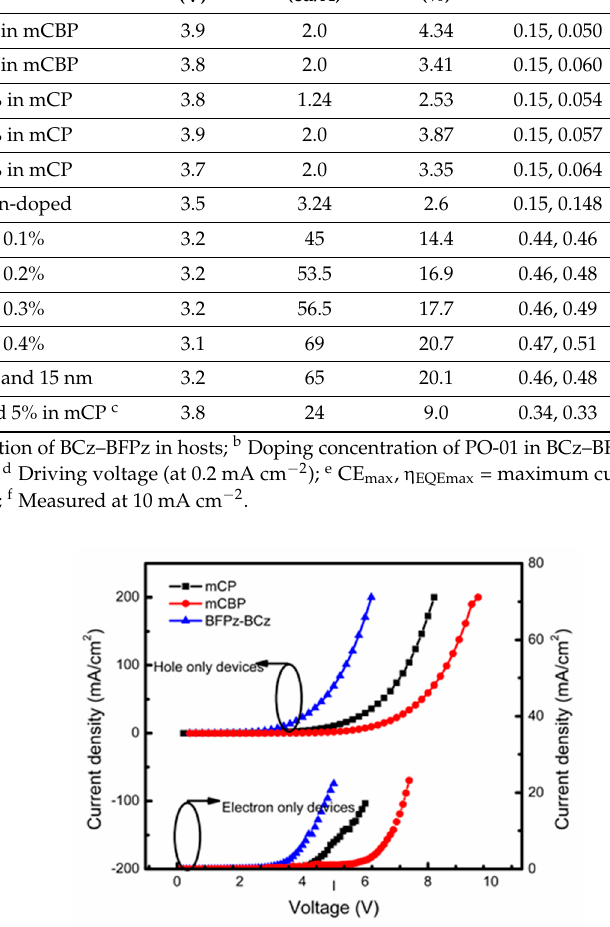
Figure 3. Current density versus voltage characteristics of the hole-only and electron-only devices.